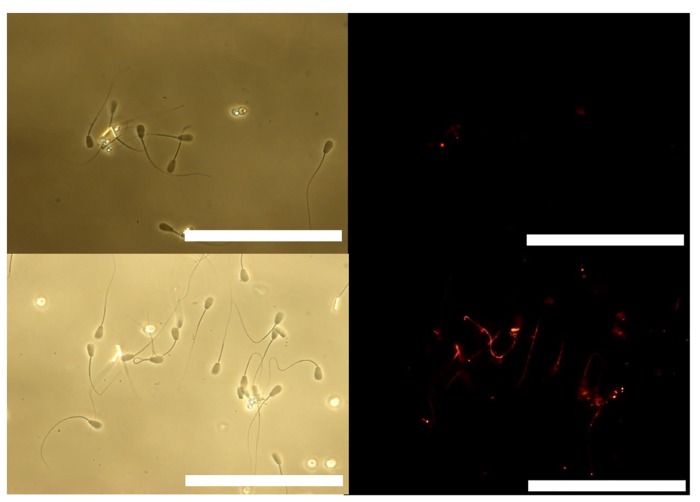
Tyrosine phosphorylation localization in sperm.Top and bottom images represent sperm cultured in non-capacitation media and capacitation media for 6hrs. Left) differential interference contrast (DIC) and right) immunofluorescence images. This experiment was repeated 3 times. Bar = 100 μm.